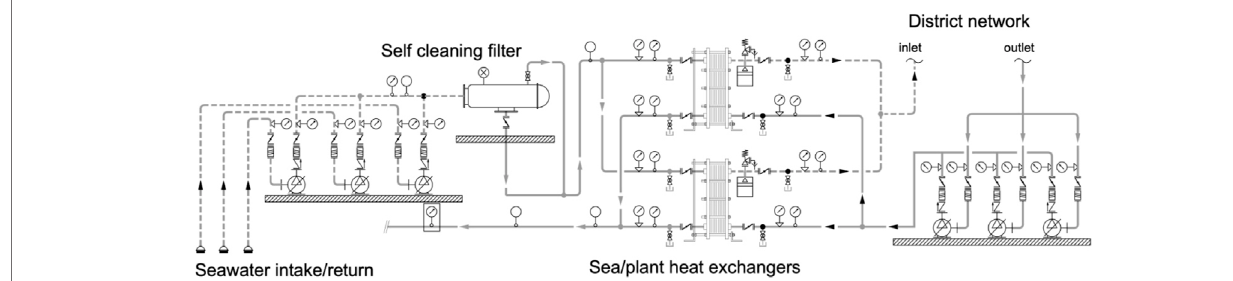
FIGURE 4 | A functional diagram of the seawater intake